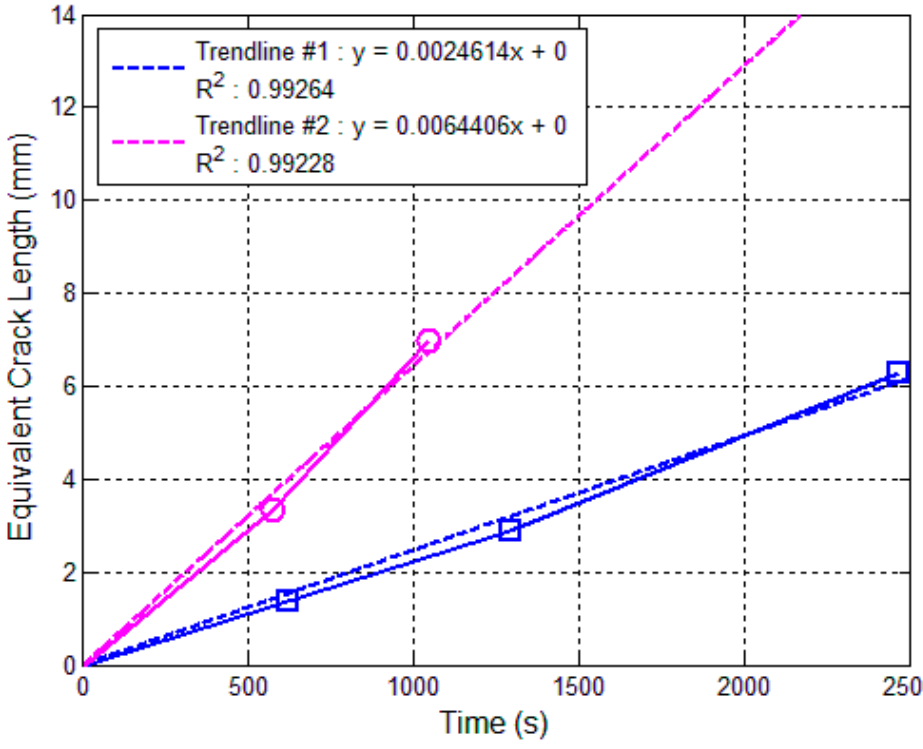
Figure 5. Equivalent crack length versus time curves related to the creep loading level of 85%.